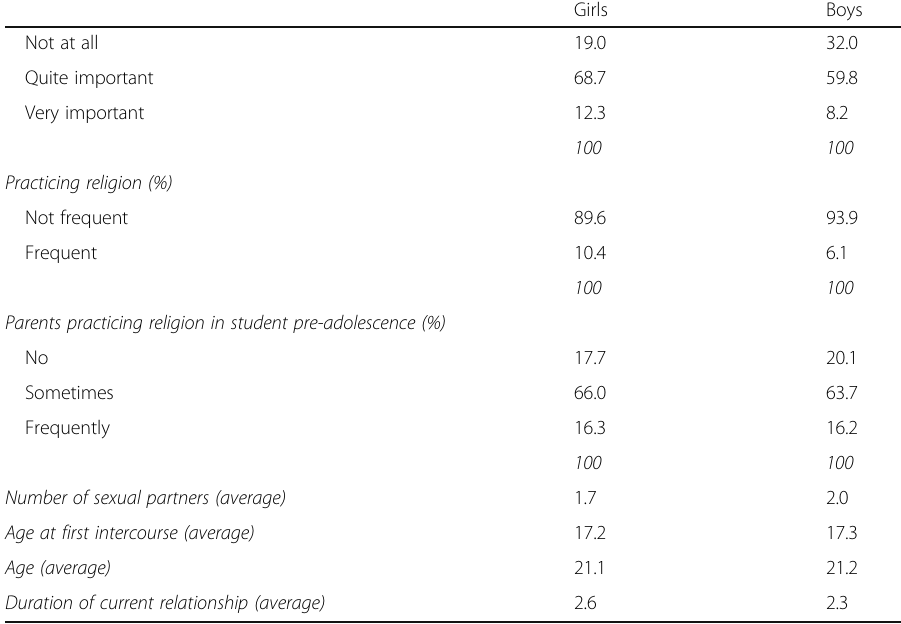
Table 1 Distribution of descriptive statistics among university students, by gender* (SELFY, 2017, weighted data) (Continued)